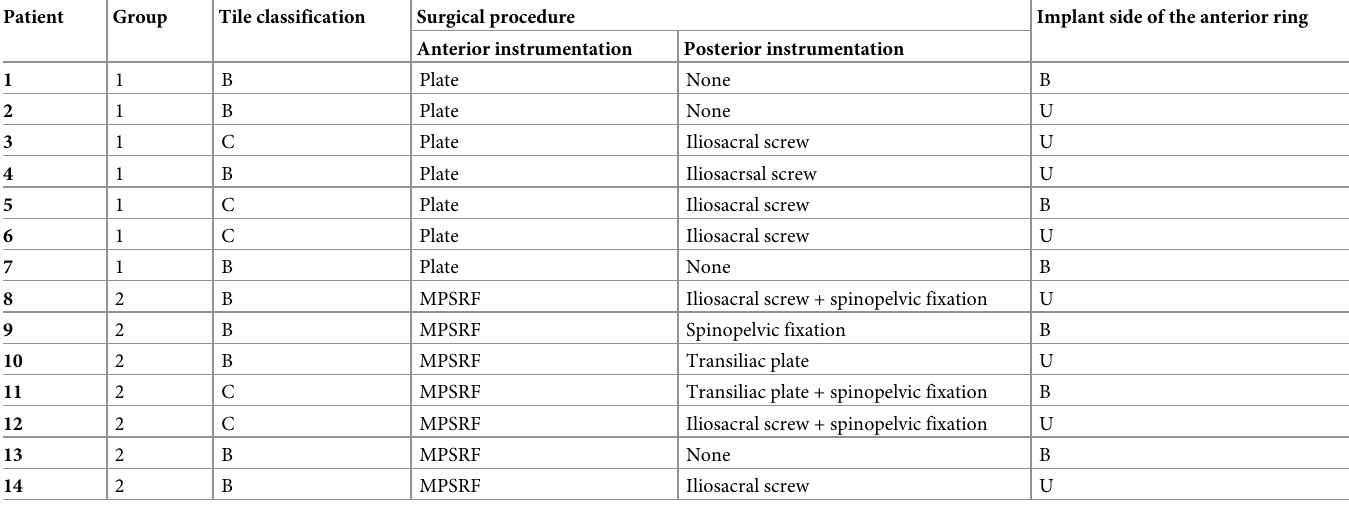
Table 2. A summary of surgical procedures used for all the patients.